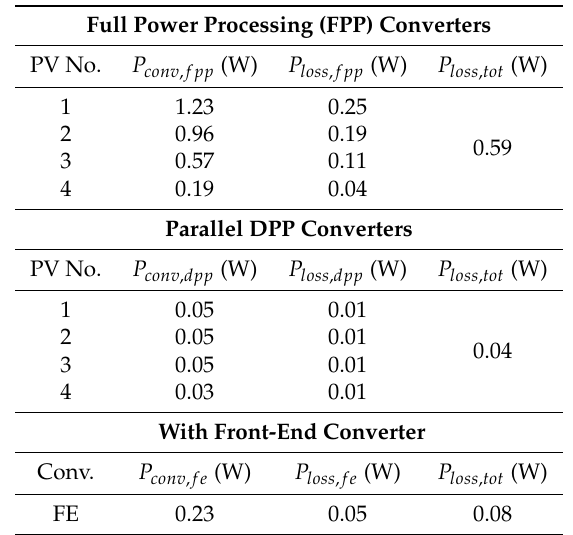
Table 1. Power Loss Comparison For Parallel MIC and